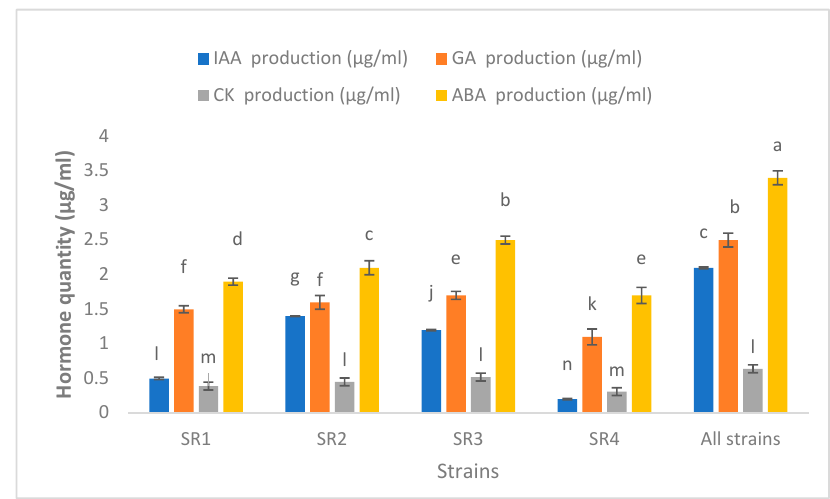
Figure 1. Production of phytohormones (Indole Acetic Acid (IAA), Gibberellic Acid (GA), Cytokinin (CK), and Abscisic Acid (ABA) by PGPR strains and their consortium in culture media. (SR 1 : Inocualted with Bacillus sp; SR 2 : Inocualted with Azospirillum brasilense ; SR 3 : Inocualted with Azospirillum lipoferum ; SR 4 : Inocualted with Pseudomonas stutzeri ; Consortium is a combination of all four strains Bacillus sp, Azospirillum brasilense, Azospirillum lipoferum, Pseudomonas stutzeri ). This data displays the means and standard deviation ( n = 3). Di ff erent letters show significant di ff erences between treatments ( p < 0.05).